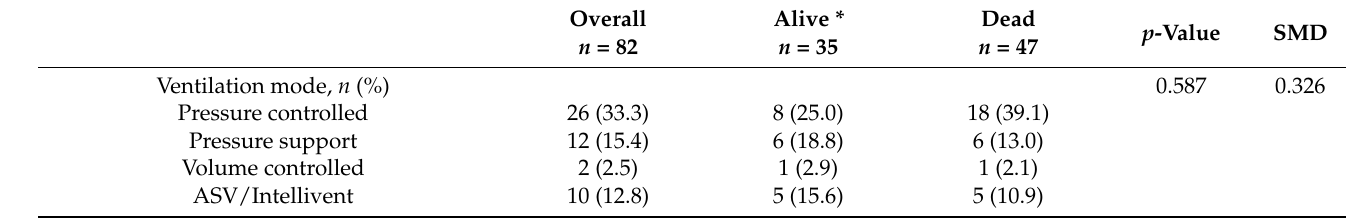
Table 2. Ventilation parameters measured with the first available combination of CXR and CT